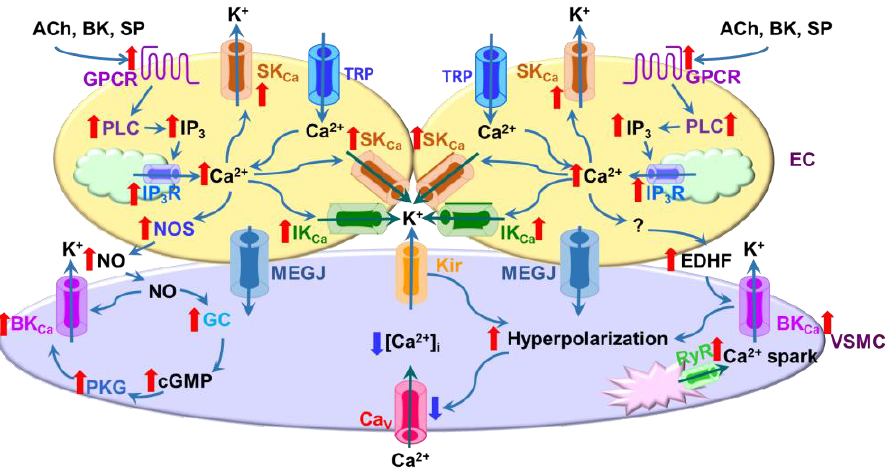
Figure 2. Regulation of vascular function by cross-talks among ion channels. The BK Ca channel is preferentially expressed in vascular smooth muscle cells (VSMCs), whereas SK Ca and IK Ca channels are primarily expressed in endothelial cells (ECs). Vasoconstriction is triggered by an increase in intracellular Ca 2+ ([Ca 2+ ] i ) in VSMCs due to Ca 2+ release from the sarcoplasmic reticulum (SR) and/or Ca 2+ influx through the Ca V 1.2 channel in the plasma membrane. Vasoconstriction is counteracted by activities of SK Ca /IK Ca channels in ECs and BK Ca channels in VSMCs. The activation of SK Ca and IK Ca channels in ECs triggered by inositol triphosphate receptor (IP 3 R)-mediated Ca 2+ release and/or transient receptor potential (TRP) channel-mediated Ca 2+ influx promotes hyperpolarization and release of nitric oxide (NO)/endothelium-derived hyperpolarizing factor (EDRF). In addition, hyperpolarization in ECs could be transmitted to VSMCs via myoendothelial gag junctions (MEGJs). The BK Ca channel is activated by RyR-mediated Ca 2+ sparks in VSMCs. BK Ca channel activity is also subject to regulation by EC-derived NO and EDHF. Moreover, the accumulation of K + ions in the intercellular space hyperpolarizes VSMCs by activating the inwardly rectifying K + (K ir ) channel. Overall, these events promote hyperpolarization of VSMCs, which in turn leads to the closure of the Ca V 1.2 channel and subsequent vasodilation. ACh, acetylcholine; BK, bradykinin; SP, substance P; GPCR, G protein-coupled receptor; PLC, phospholipase C; NOS, nitric oxide synthases; GC, guanylate cyclase; cGMP, cyclic guanosine monophosphate; PKG, protein kinase G.